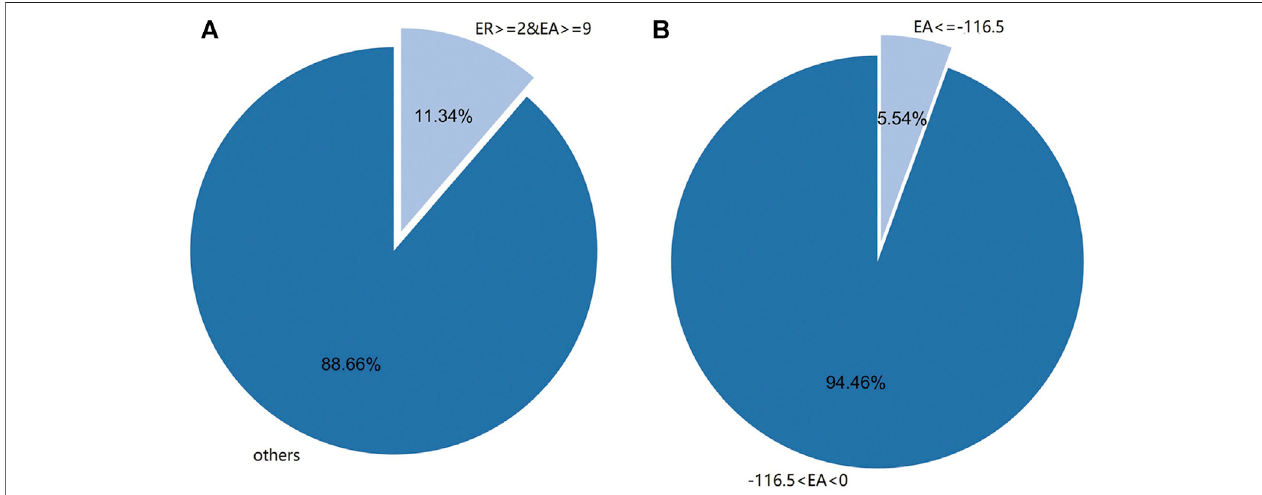
FIGURE 3 | (A) The distribution of differential expression rate (ER) ofsRNAs of M. oryzae was greater than or equal to 2 and the expression amount (EA) was more signi fi cant than or equal to 9. (B) The distribution of differential EA of sRNAs of M. oryzae was less than or equal to − 116.5.